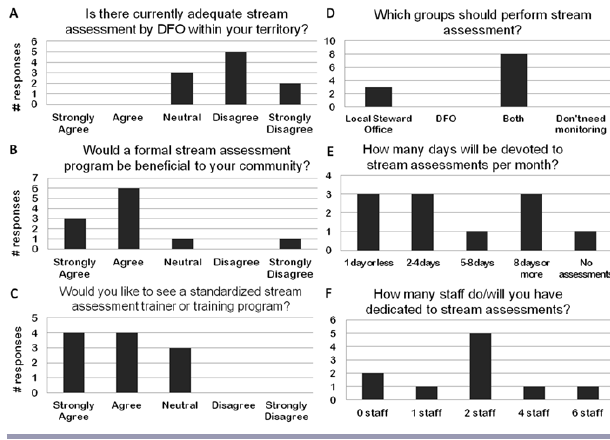
Fig. 5 . Responses to the categorical questions of our